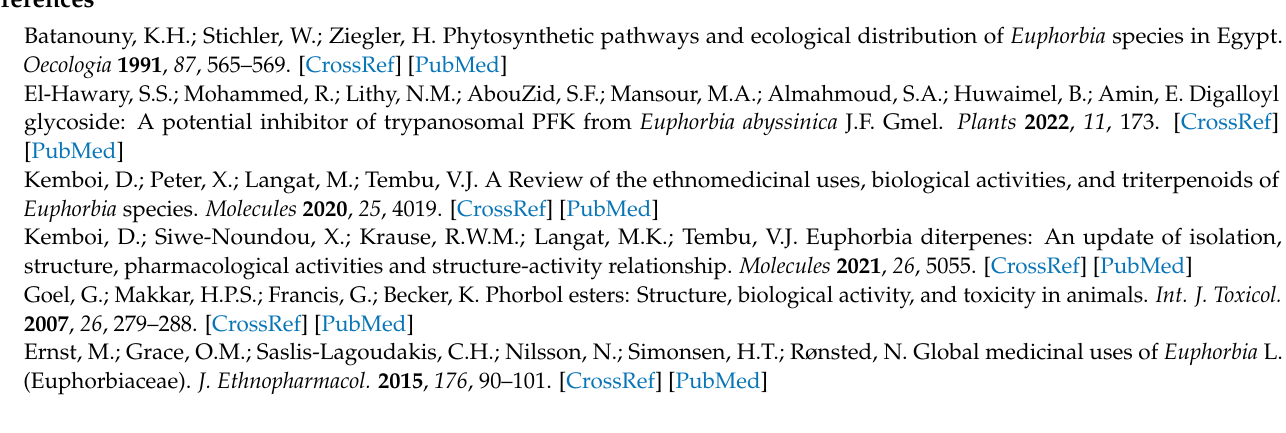
euphocactoside ( 5 ), Figure S2: 13C NMR spectrum (DMSO-d6) of euphocactoside ( 5 ), Figure S3: DEPT135 NMR spectrum (DMSO-d6) of euphocactoside ( 5 ), Figure S4: COSY NMR spectrum (DMSO-d6) of euphocactoside ( 5 ), Figure S5: HMBC NMR spectrum (DMSO-d6) of euphocactoside ( 5 ), Figure S6: HSQC NMR spectrum (DMSO-d6) of euphocactoside ( 5 ), Figure S7: ROESY NMR spectrum (CD3OD) of euphocactoside ( 5